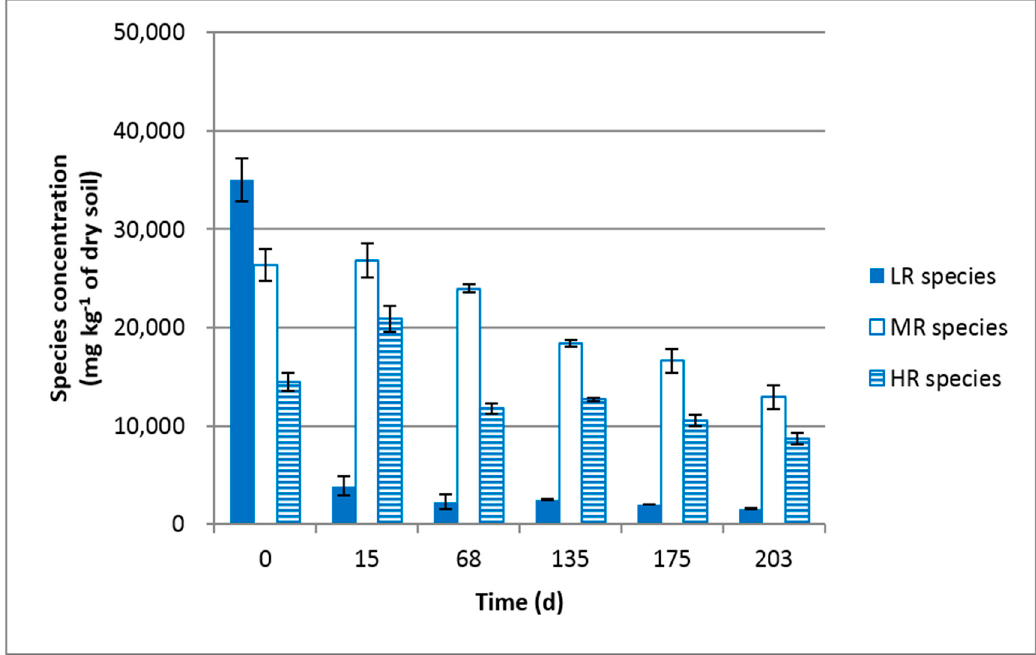
Figure 6. Change in residual diesel oil composition during the process for the abiotic microcosm. Figure 7. Change in residual diesel oil composition during the process for the BIOS